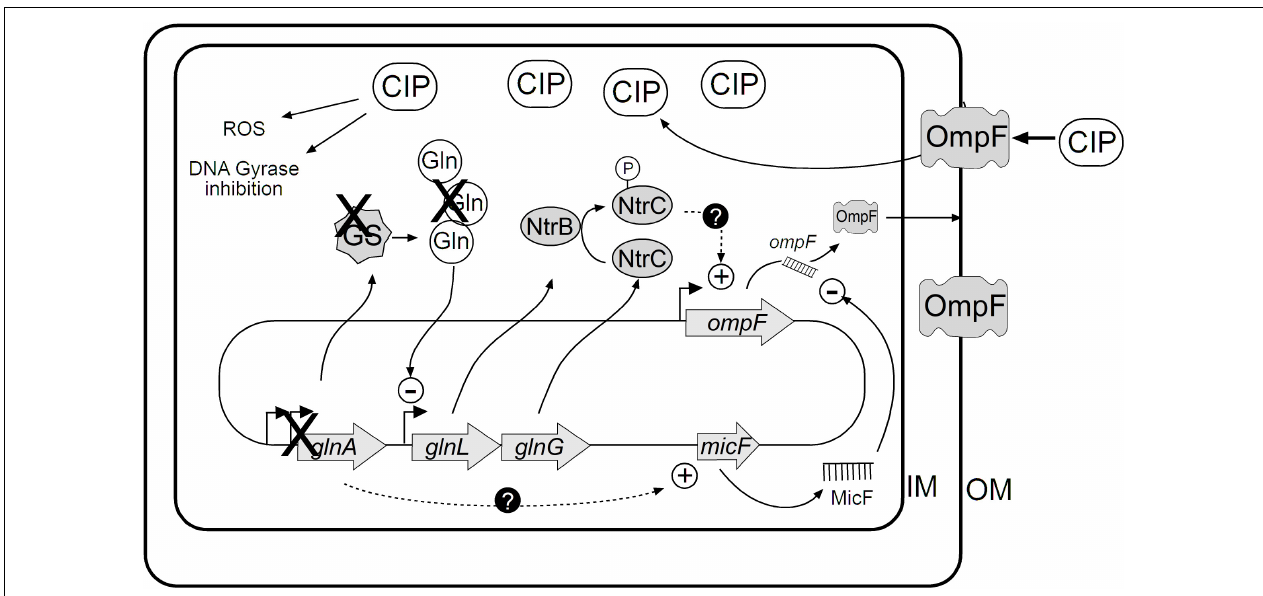
FIGURE 6 | Integrative model of the regulation of OmpF and its implication in susceptibility to CIP. Expression of OmpF is negatively controlled by GlnA. Proposed model illustrating how glnA gene is necessary to maintain low expression of OmpF. Based in our data, deleting glnA gene promotes ompF expression that in turns facilitates CIP and nalidixic acid entry into the bacterial cell through